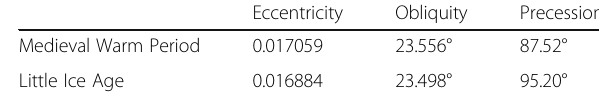
Table 2 Orbital parameters for MRI-CGCM2.3 orbital forcing